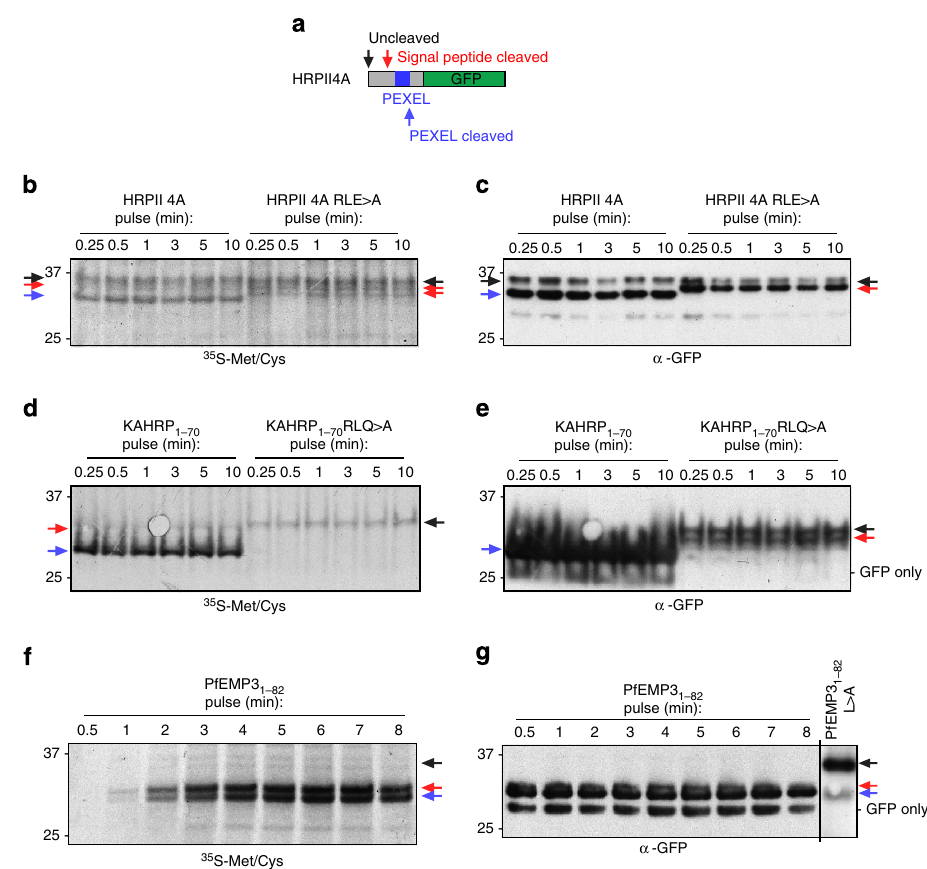
Figure 6 | The PEXEL is cleaved co-translationally. ( a ) Top: schematic of PEXEL proteins and their cleavage positions. ( b ) 35 S-methionine/cysteine- labelling ( 35 S-Met/Cys) of HRPII 4A and HRPII 4A RLE 4 A in P. falciparum for the indicated times shows bands corresponding to uncleaved (black arrow), signal peptide-cleaved (red arrow) and PEXEL-cleaved (blue arrow) species. Two signal peptide-cleaved species are present for RLE 4 A (red arrows), possibly due to insertion of four alanines following the signal sequence. ( c ) Immunoblot with anti-GFP antibodies of the same membrane shows the bands are GFP specific. ( d ) 35 S-Met/Cys-labelling of KAHRP 1–70 and KAHRP 1–70 -RLQ 4 A in P. falciparum . Bands corresponding to uncleaved (black arrow), signal peptide-cleaved (red arrow) and PEXEL-cleaved (blue arrow) species are indicated. ( e ) Immunoblot with anti-GFP antibodies of the same membrane. Note the absence of a signal peptidase cleaved product for KAHRP 1–70 RLQ 4 A in the autoradiography that is present in the immunoblot as the latter reveals protein produced over hours. This shows signal peptidase activity was inefficient. ( f ) 35 S-Met/Cys-labelling of PfEMP3 1–82 in P. falciparum . Bands corresponding to cleavage of the indented signal peptide (red arrow) and PEXEL (blue arrow) are indicated. ( g ) Immunoblot with anti-GFP antibodies of the same membrane. A PEXEL mutant (PfEMP3 1–82 L 4 A) was included as a size control. Most protein detected with anti-GFP was present before radiolabelling; thus, quantity is not comparable to 35 S-Met/Cys. Incorporation of 35 S-Met/Cys into HRPII and KAHRP constructs did not increase appreciably over time, in contrast to PfEMP3. The reason for this is unknown but may be due to saturation of anti-GFP agarose in the former experiments, which was used to enrich the GFP proteins. Full-length gels for all panels shown in Supplementary Fig.